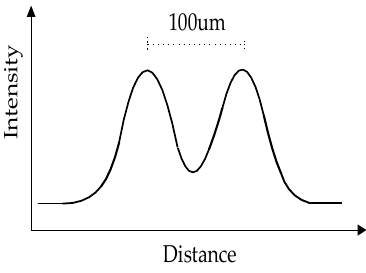
Figure 2. Light intensity pro fi le over measurement volume.